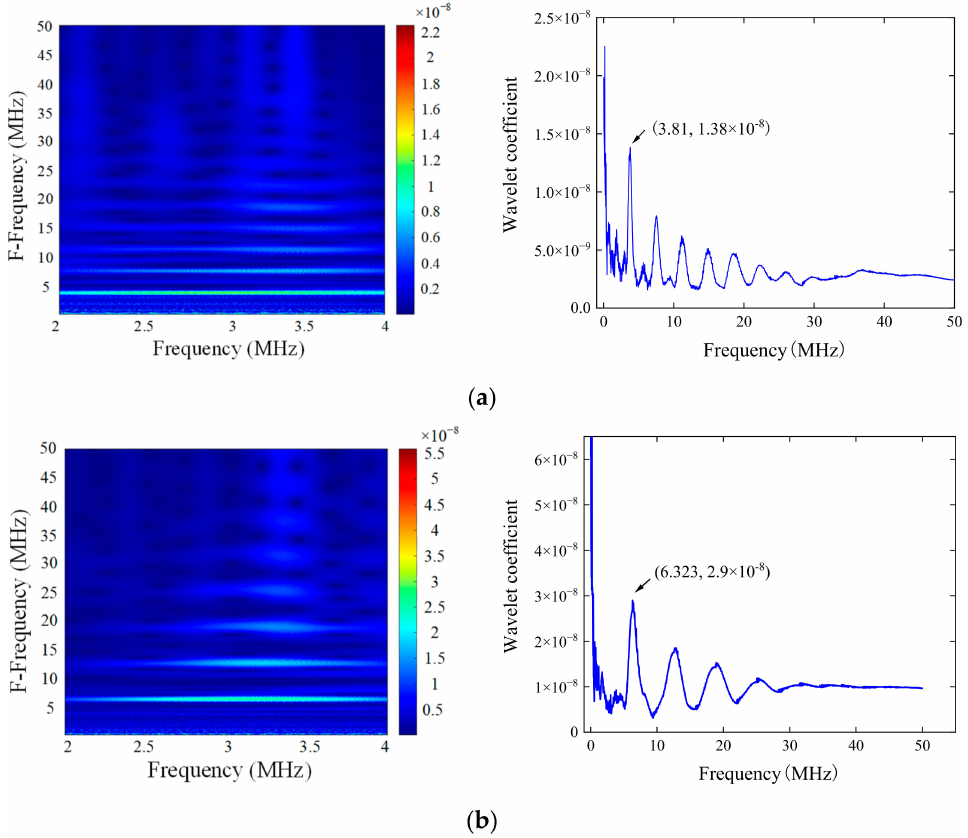
Figure 8. F-Frequency energy density precipitation results of different thicknesses. ( a ) F—Frequency analysis diagram of 6 mm thickness. ( b ) F—Frequency analysis diagram of 10 mm